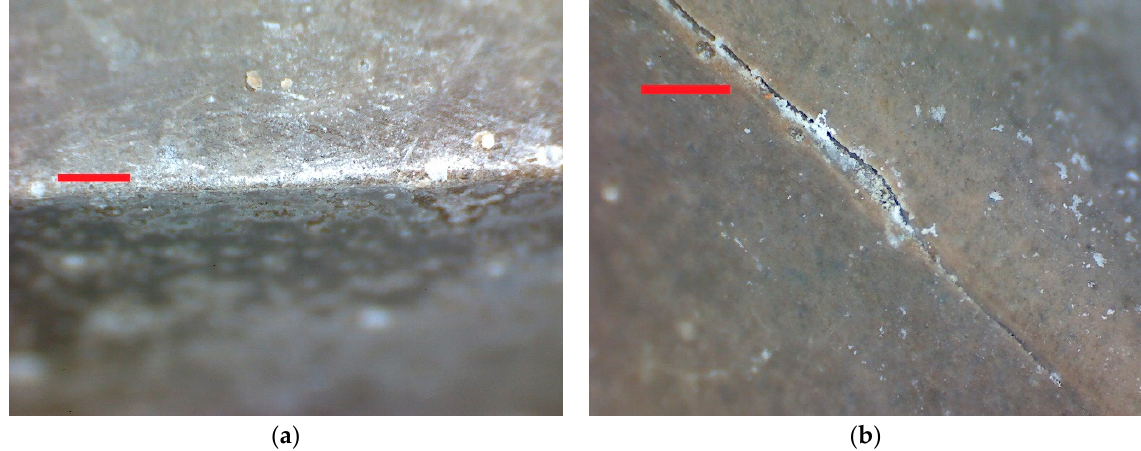
Figure 15. M6 after 420 days in the sulfate bath: ( a ) most specimen edges do not exhibit any signs of cracking; ( b ) first hairline cracks can be observed on one of the four specimens; the red line indicates a length of 1 mm.